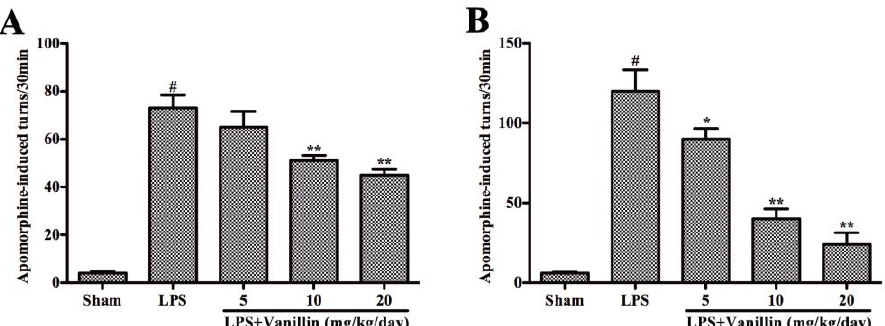
Figure 1. Vanillin administration improves the motor dysfunction by lipopolysaccharide (LPS) intranigral injection. Rats were treated with the vehicle or vanillin (5, 10, or 20 mg/kg/day) for three days prior to LPS intranigral injection and this lasted for 24 days. The number of turns after two ( A ); and four weeks ( B ) was induced by apomorphine in Parkinson’s disease (PD) model rats. # p < 0.01 vs. the sham-operated control rats; and * p < 0.05 and ** p < 0.01 vs. the vehicle treated LPS-injected rats.